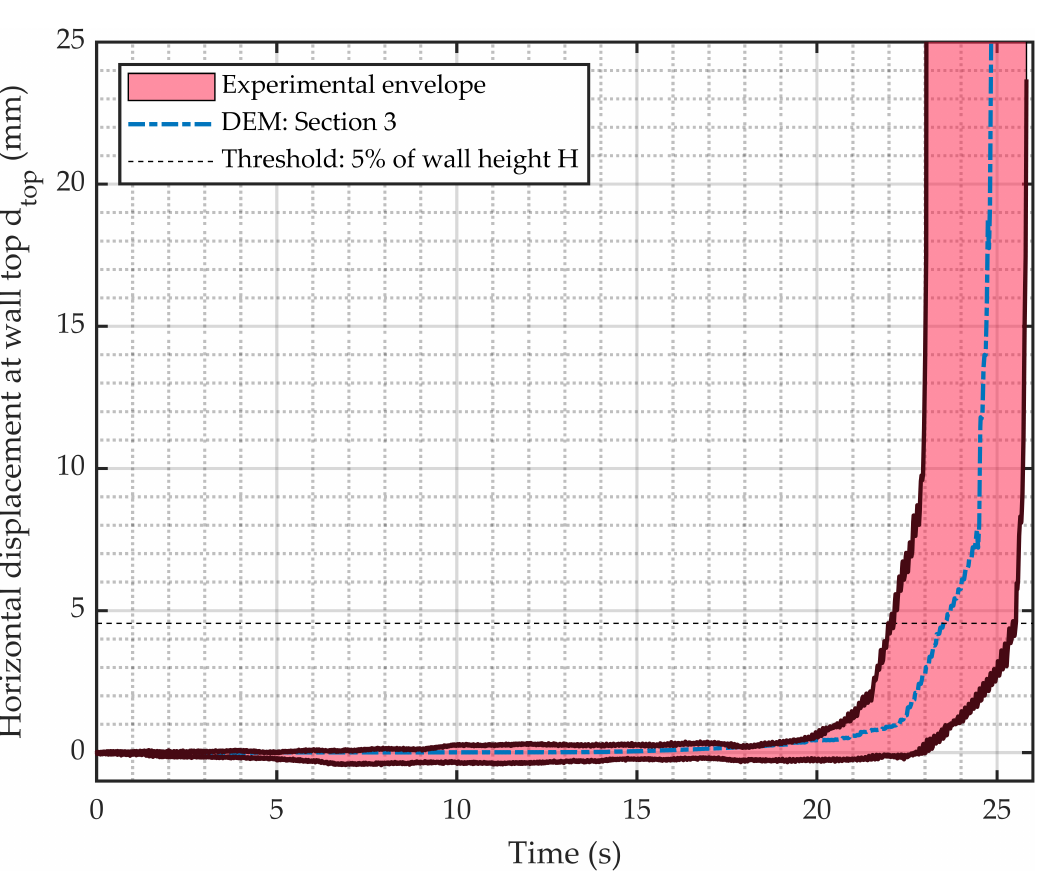
Figure 5. Comparison of the numerical response with the envelop of the experimental results [33] for walls with a slenderness H/B = 2.3.